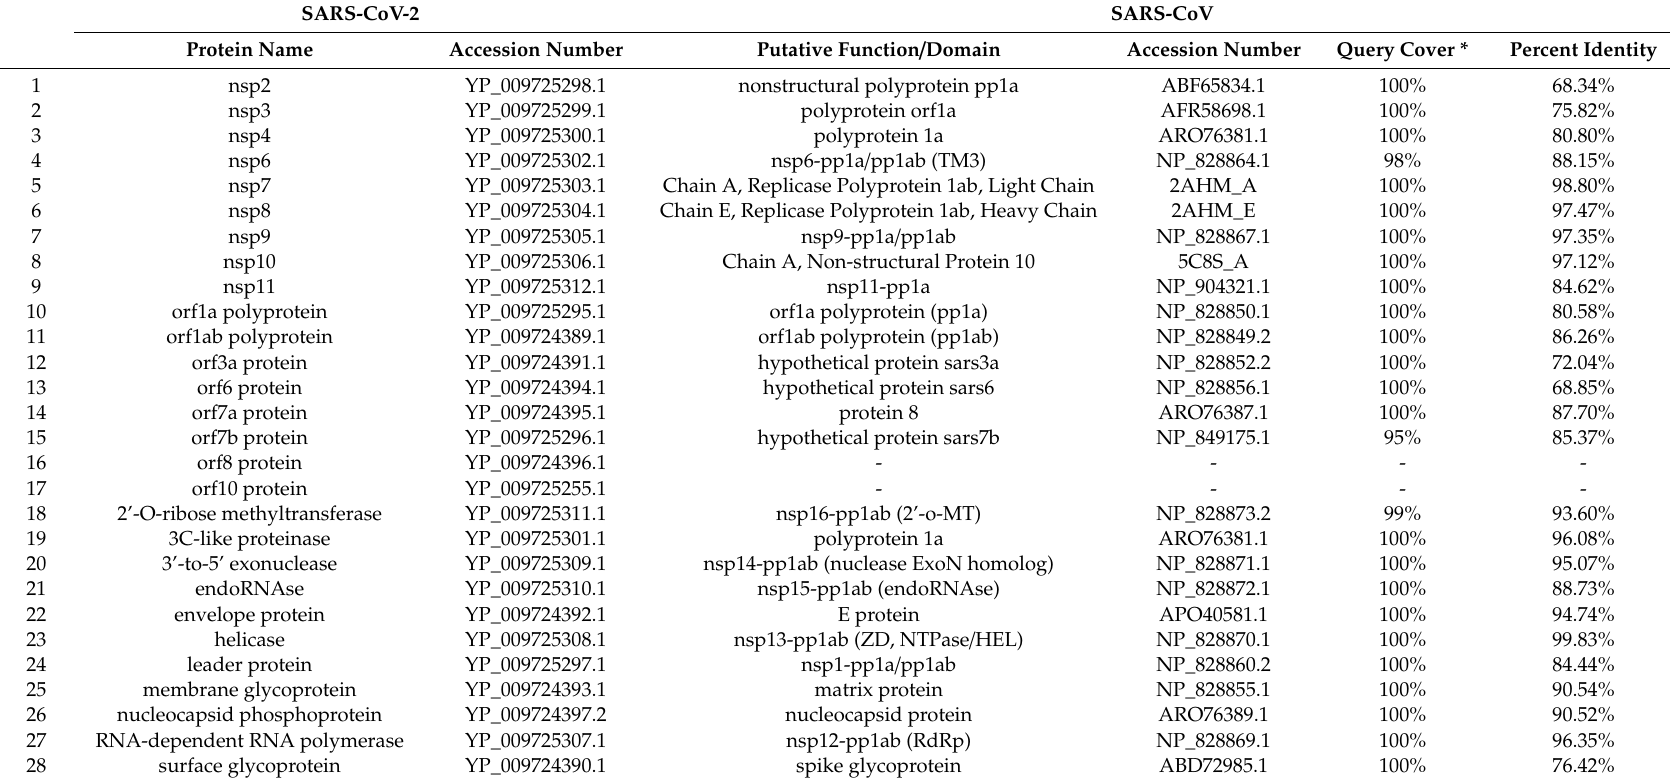
Table 2. Comparison of protein sequences SARS-CoV-2 and SARS-CoV by